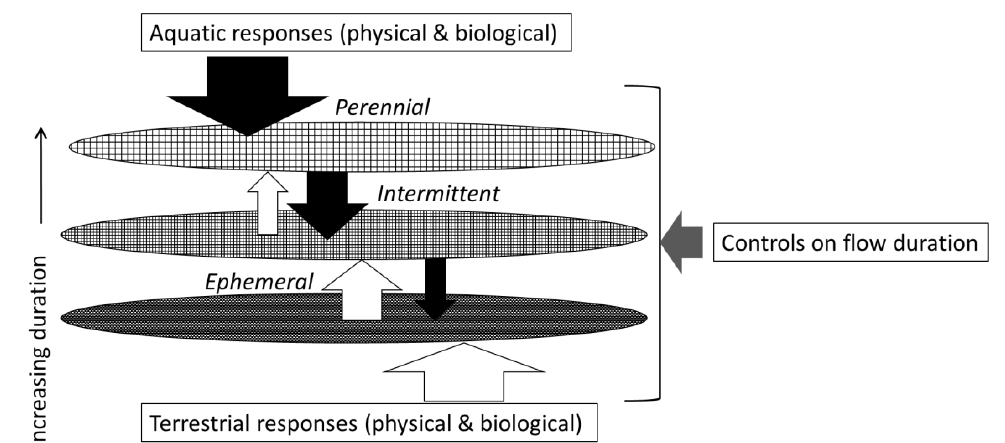
Figure 2. Conceptual figure illustrating indicators of streamflow duration. Response indicators are “filtered” along the gradient of streamflow duration, such that the strength of aquatic signal (black arrows; e.g., stream biota, fluvial geomorphology) declines and terrestrial signal (white arrows; e.g., terrestrial biota, soil development) increases with decreasing flow duration. Control indicators (gray arrow) are factors that govern streamflow duration from reach to landscape scales (e.g., meteorology, geology, land